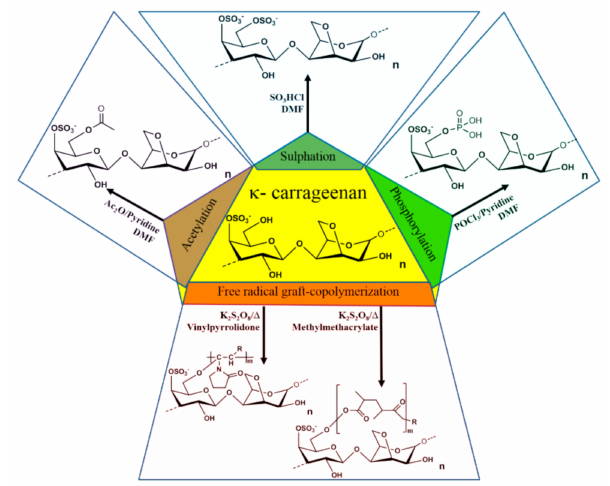
Figure 3. Derivatization of carrageenan via free radical graft-copolymerization, sulphation, acetyla- tion, and phosphorylation.